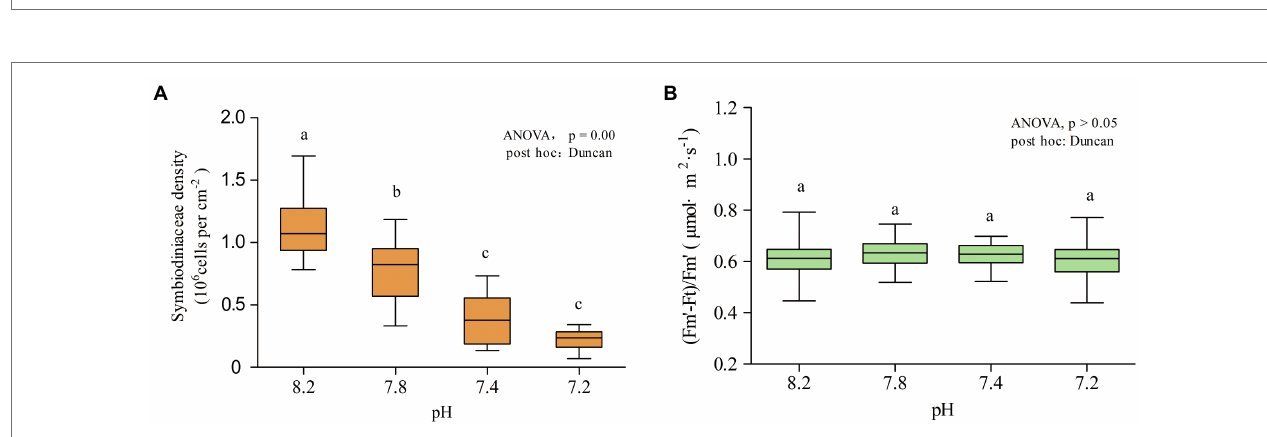
FIGURE 2 | Symbiodiniaceae density and chlorophyll fluorescence at different pH gradients. Each pH condition lasted 10 days. (A) Density of Symbiodiniaceae. (B) ( F m ′ - F t )/ F m ′ . Lower case letters (a, b, c) denote differences by Duncan post hoc